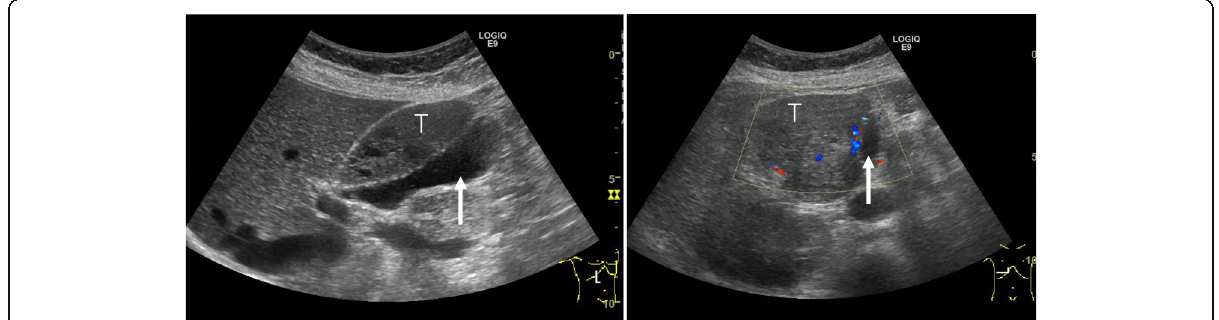
Fig. 2 Abdominal ultrasonography showed a tumor (T) with a clear border between the gallbladder (white arrow) and the